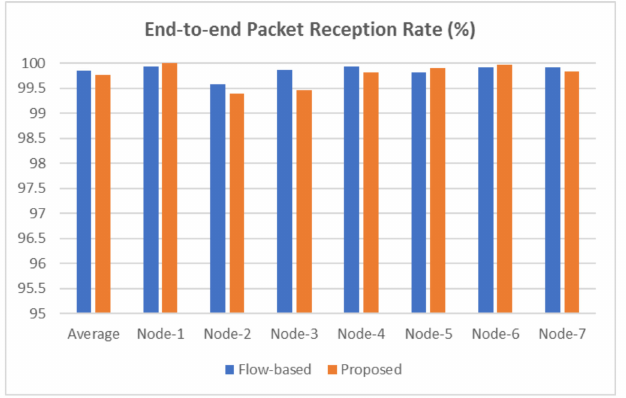
Figure 5. End-to-end reliability of the proposed algorithm and the flow-based approach.